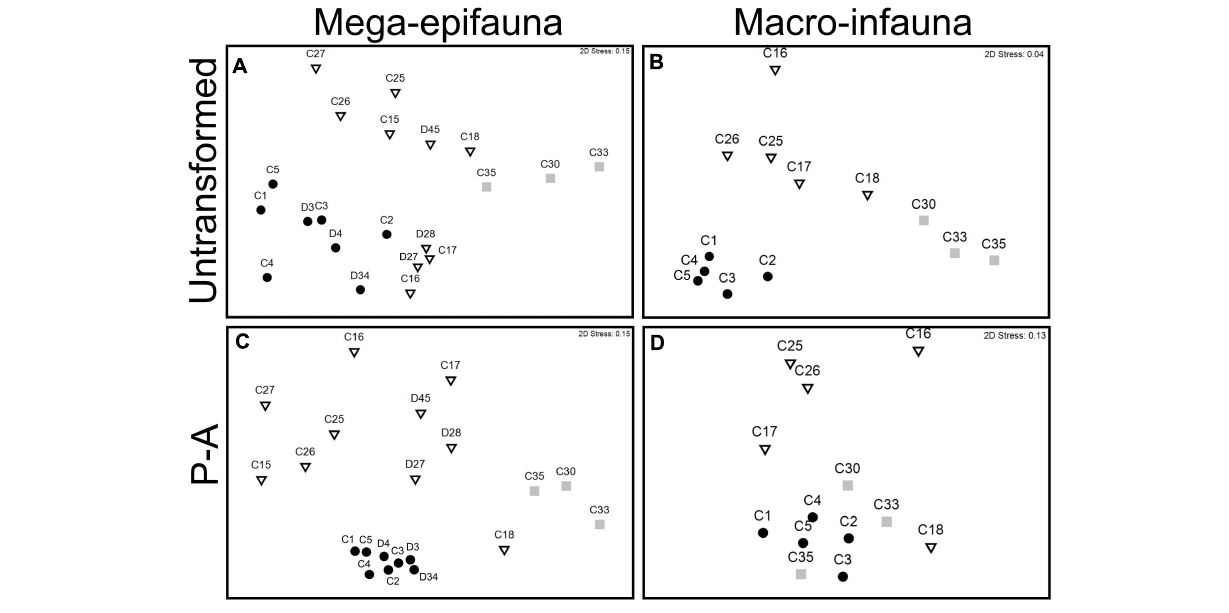
slope = 80.34%, abyss vs. shelf = 90.85%, abyss vs. slope =